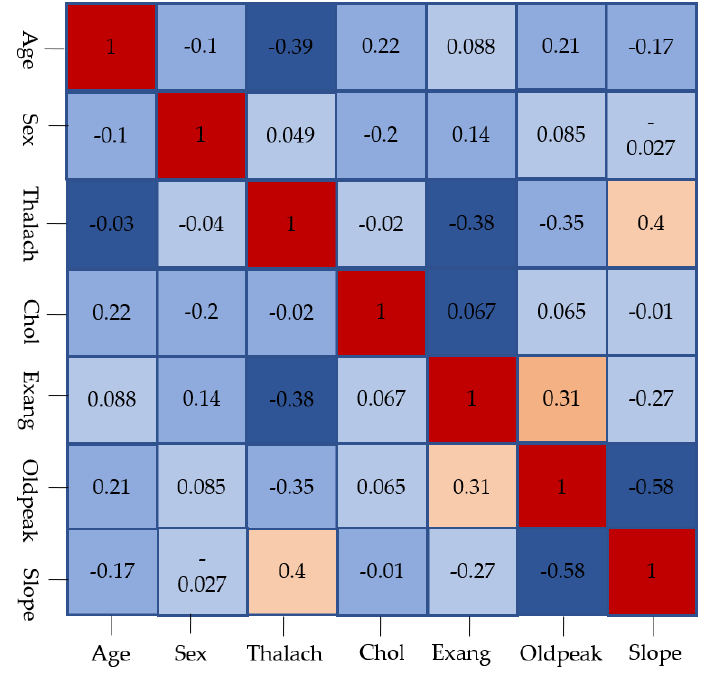
Figure 3. Various attributes of the UCI dataset are visualized using a heat